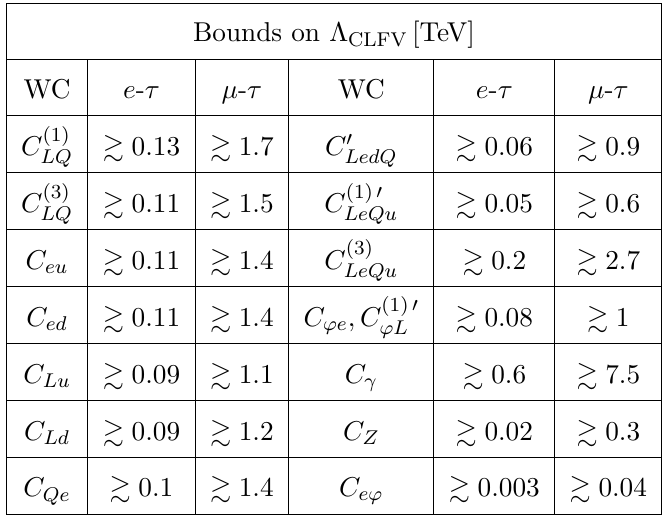
Table 3 . Bounds on the new-physics energy scale mediating CLFV phenomena ( Λ CLFV ), both for e - τ and µ - τ conversion in Fe(56,26). Here, we consider C ≈ 1 . The results are based on the expected sensitivity of the NA64 experiment, given at the 99.8 % confidence